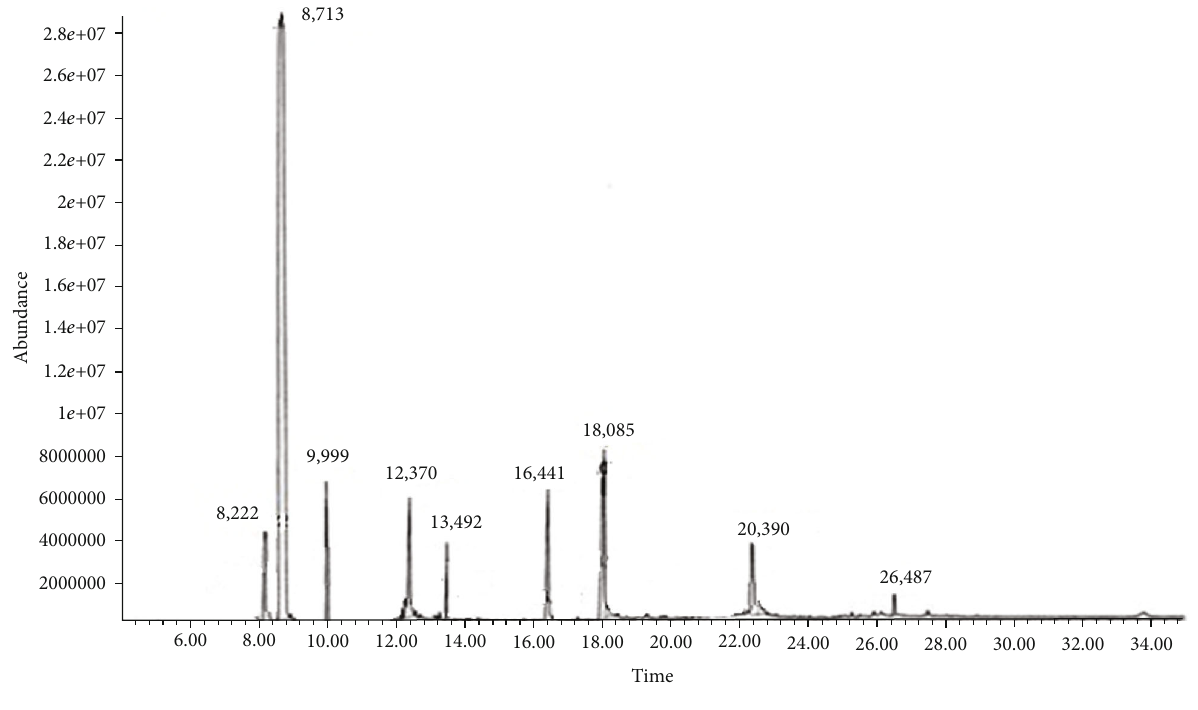
Figure 1: GCMS analysis of star anise extract.